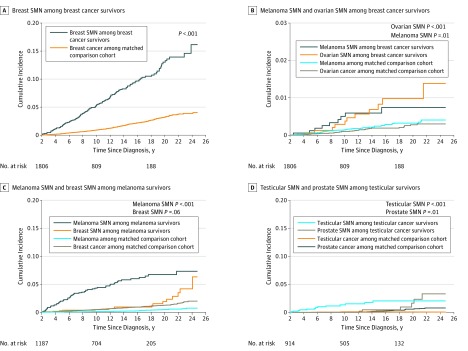
Cumulative Incidence Function Considering Competing Risk Among Survivors of Adolescent and Young Adult Cancer by Second Malignant Neoplasm (SMN) and First Cancer TypeThe P value compares SMN incidence by cancer survivor status using the Fine and Gray method. A different scale for the y axis is used in panel B to allow the visual distinction of curves.